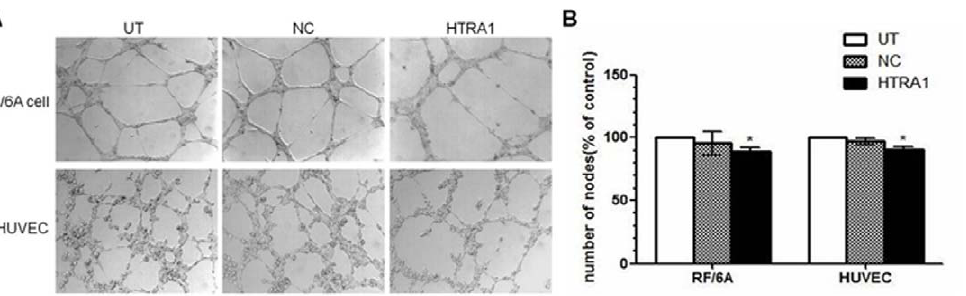
Figure 6. Effect of HTRA1 on tube formation in RF/6A cells and HUVECs. After 24 h of incubation, untransfected control cells (A) and lentiviral vector control group cells (B) formed well-organized, capillary-like structures, while the capacity of HTRA1-transfected group cells to organize was severely compromised (C, p , 0.05).